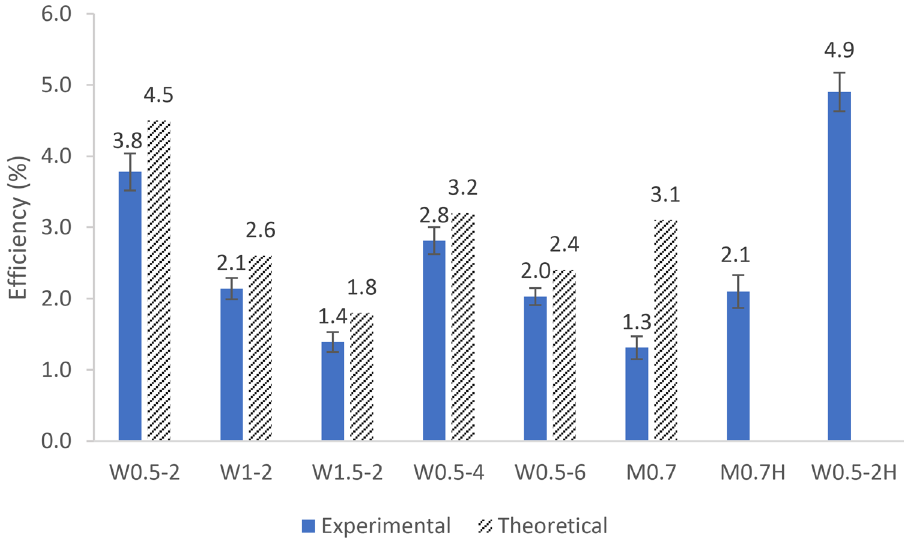
Fig. 4 Fog harvesting efficiency for each of the col-